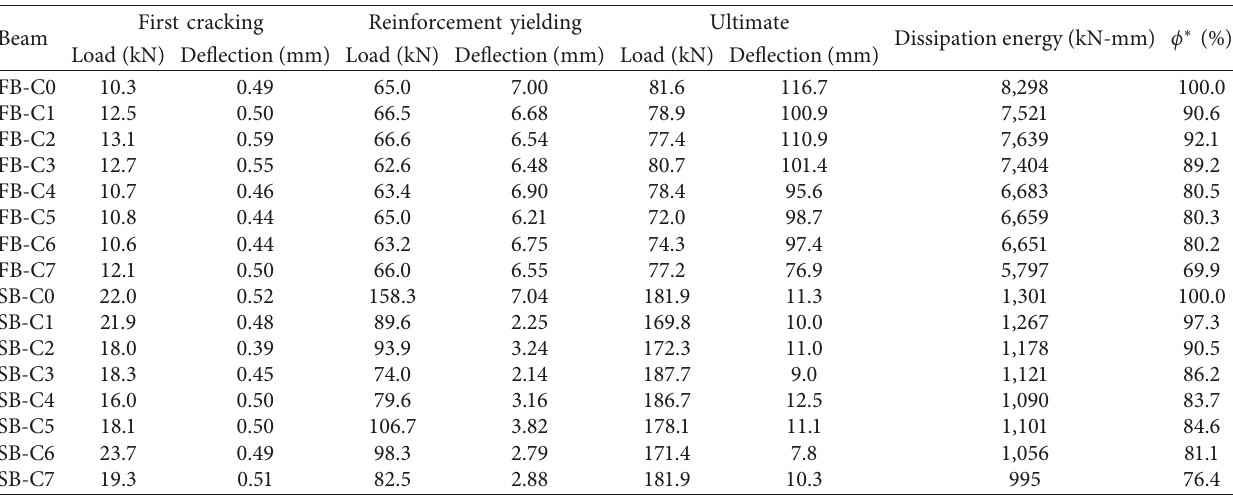
Table 2: Test results for each specimen.